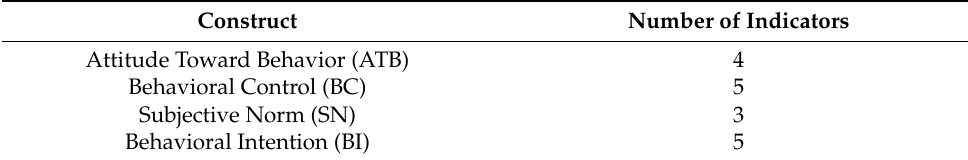
Table 2. Indicators associated with each construct.